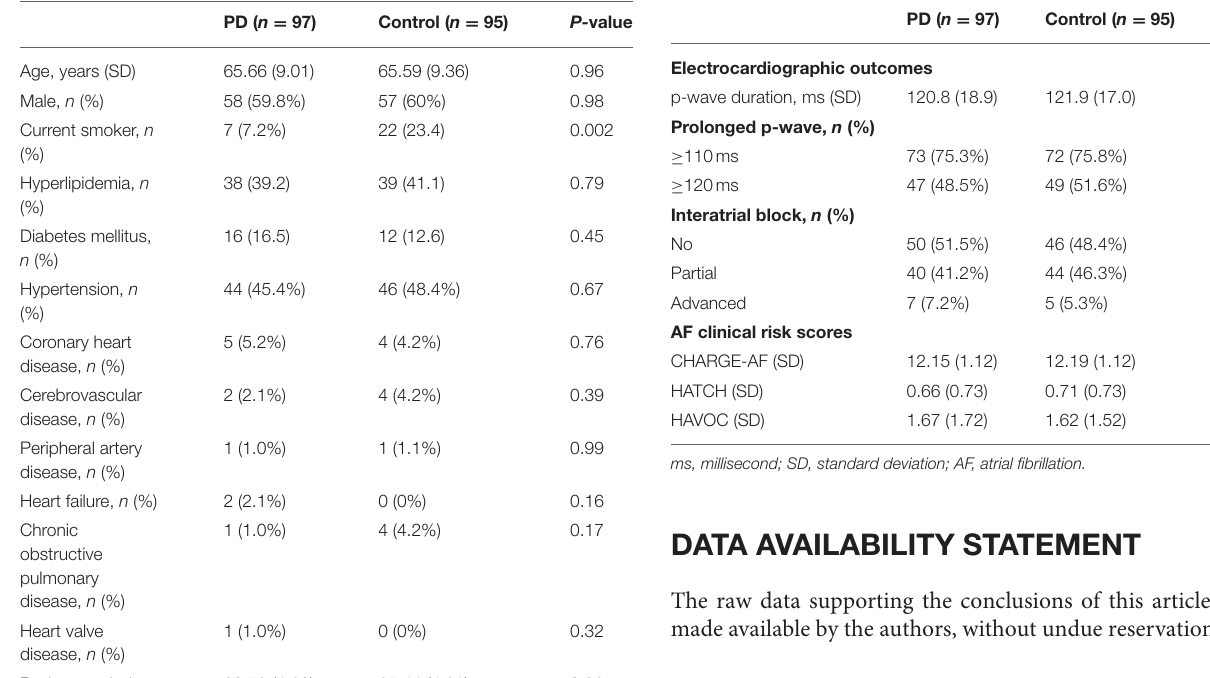
TABLE 2 | Electrocardiogram outcomes and clinical risk scores predictors of atrial